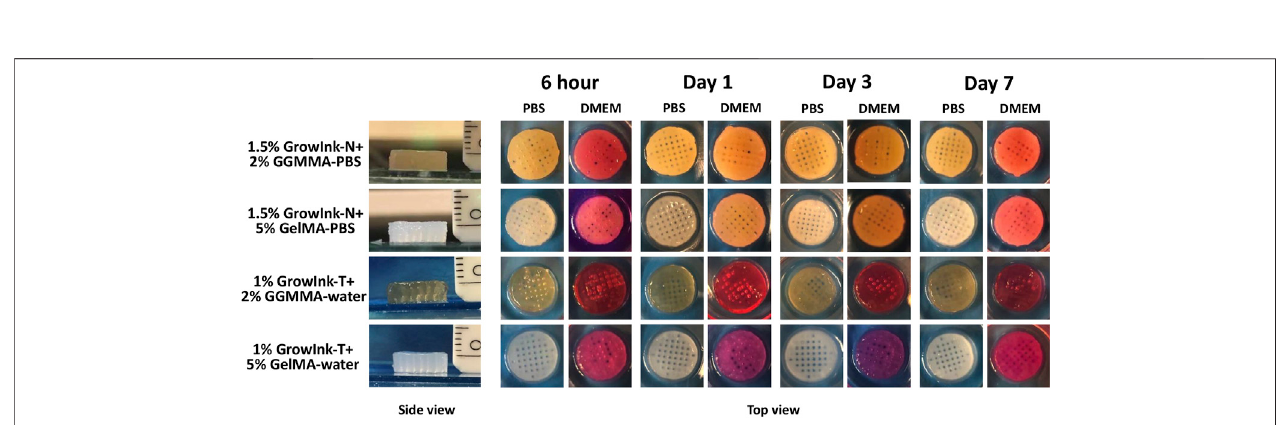
FIGURE 7 | Side and top views of the printed hydrogel scaffolds incubated in PBS buffer and DMEM for 7 days.